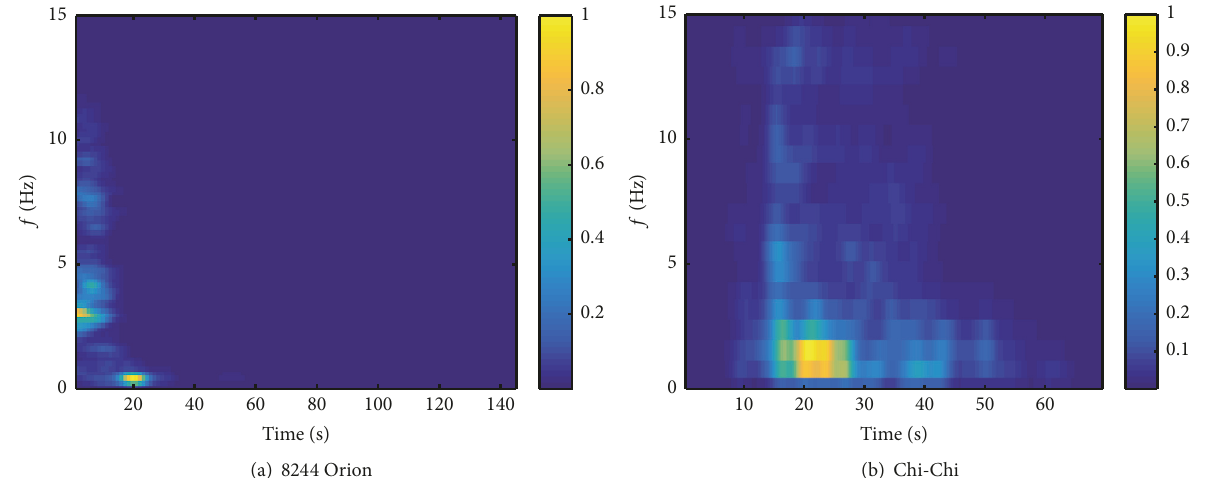
Figure 3: Time-varying power spectra of the 8244 Orion and Chi-Chi accelerograms.